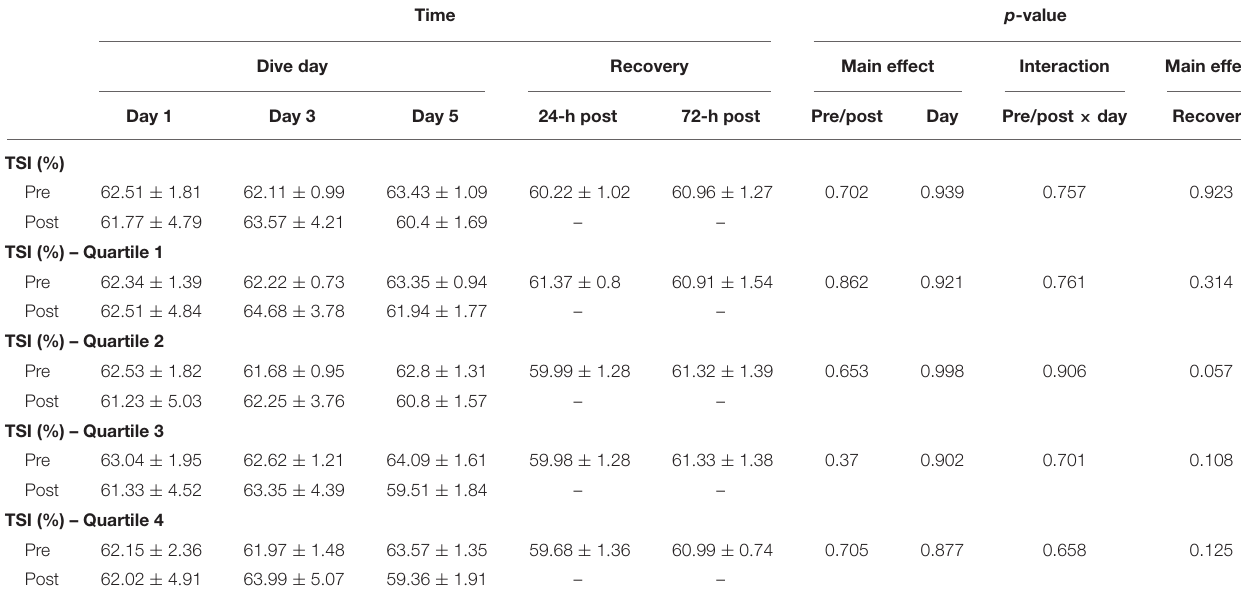
TABLE 3 | Forty percent MHE total saturation index (TSI)